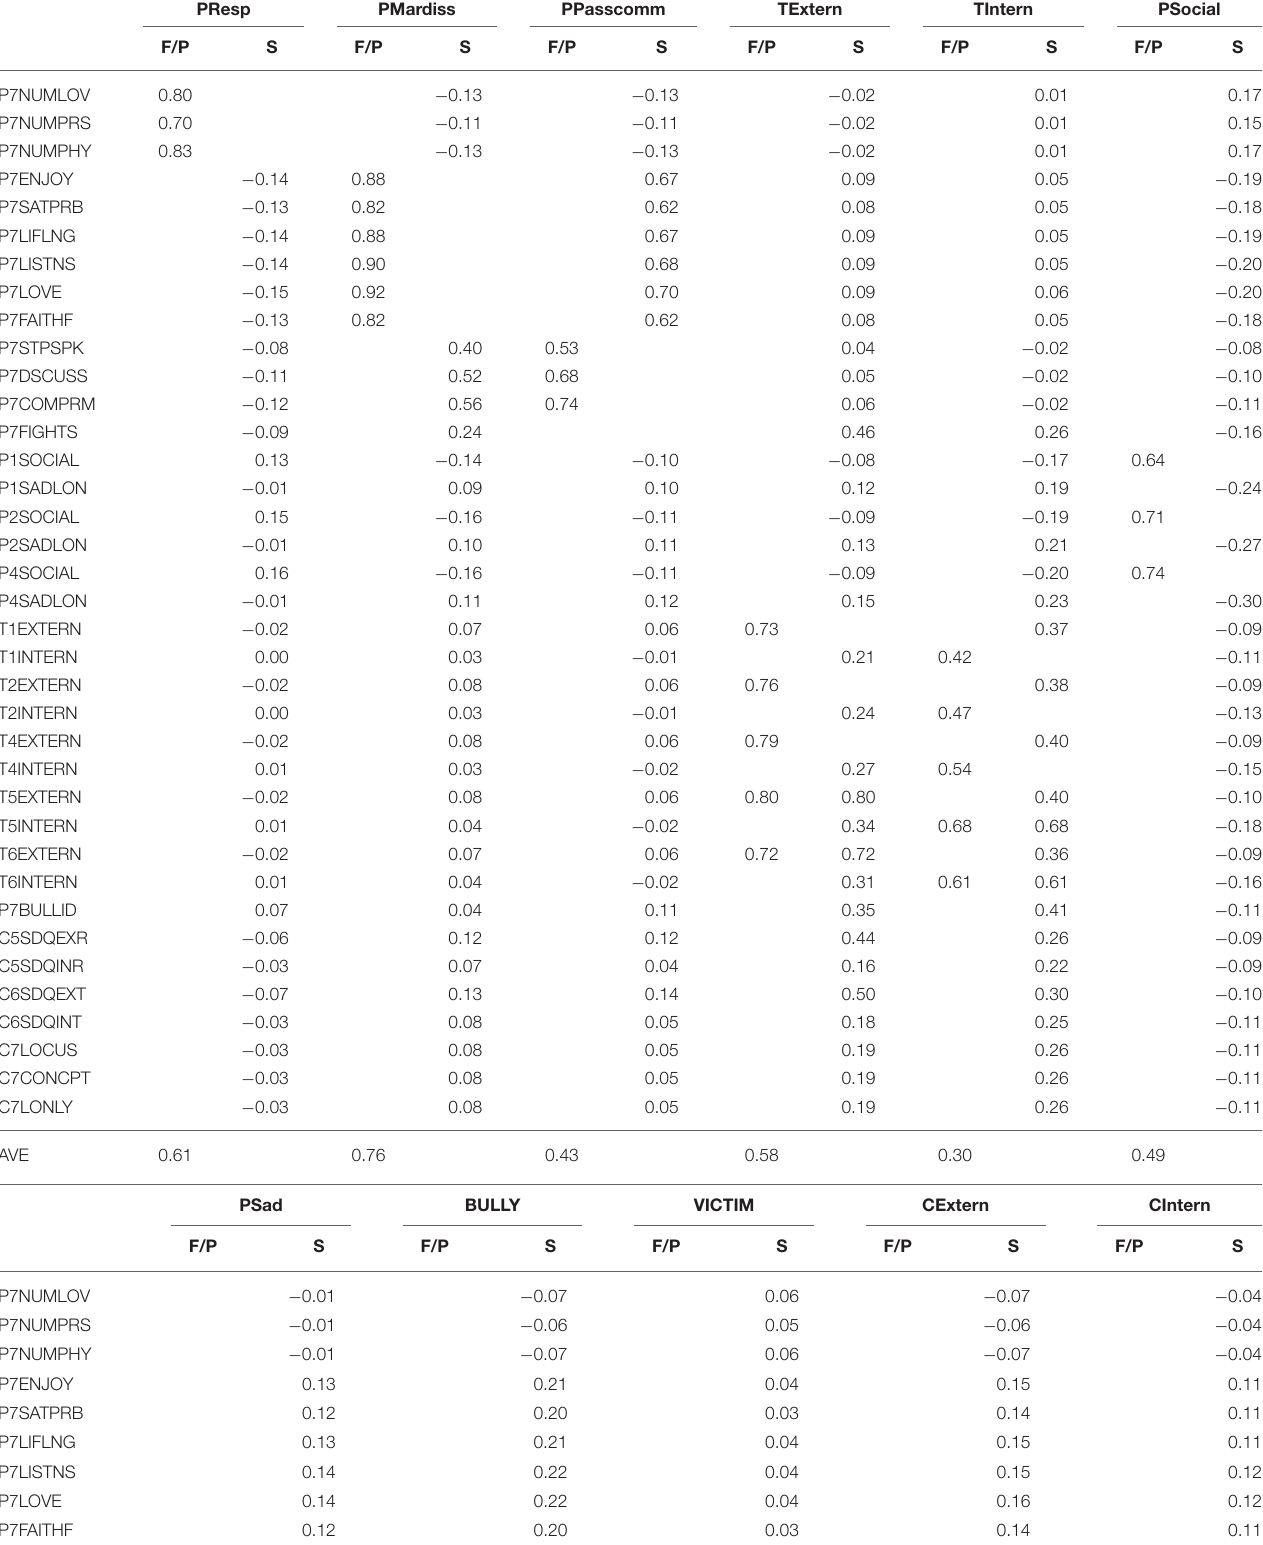
TABLE 4 | Standardized factor pattern and structural coefficients of factors. PResp PMardiss PPasscomm TExtern TIntern